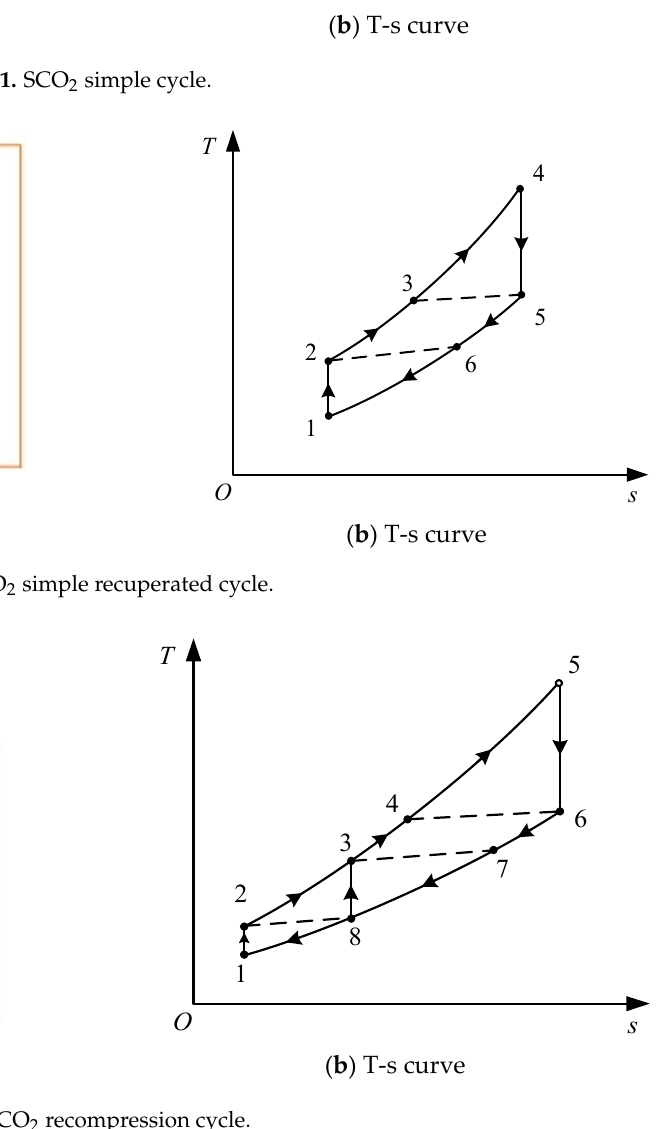
Figure 1. SCO 2 simple cycle.